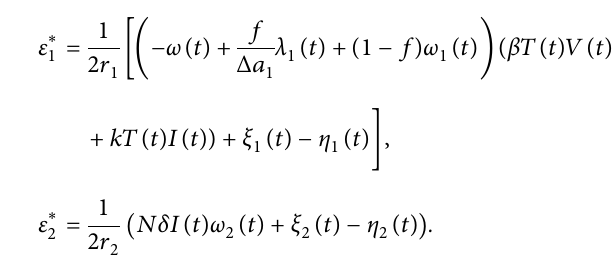
� 2 . 1108 > 1, which ensures that the infected equilibrium 0